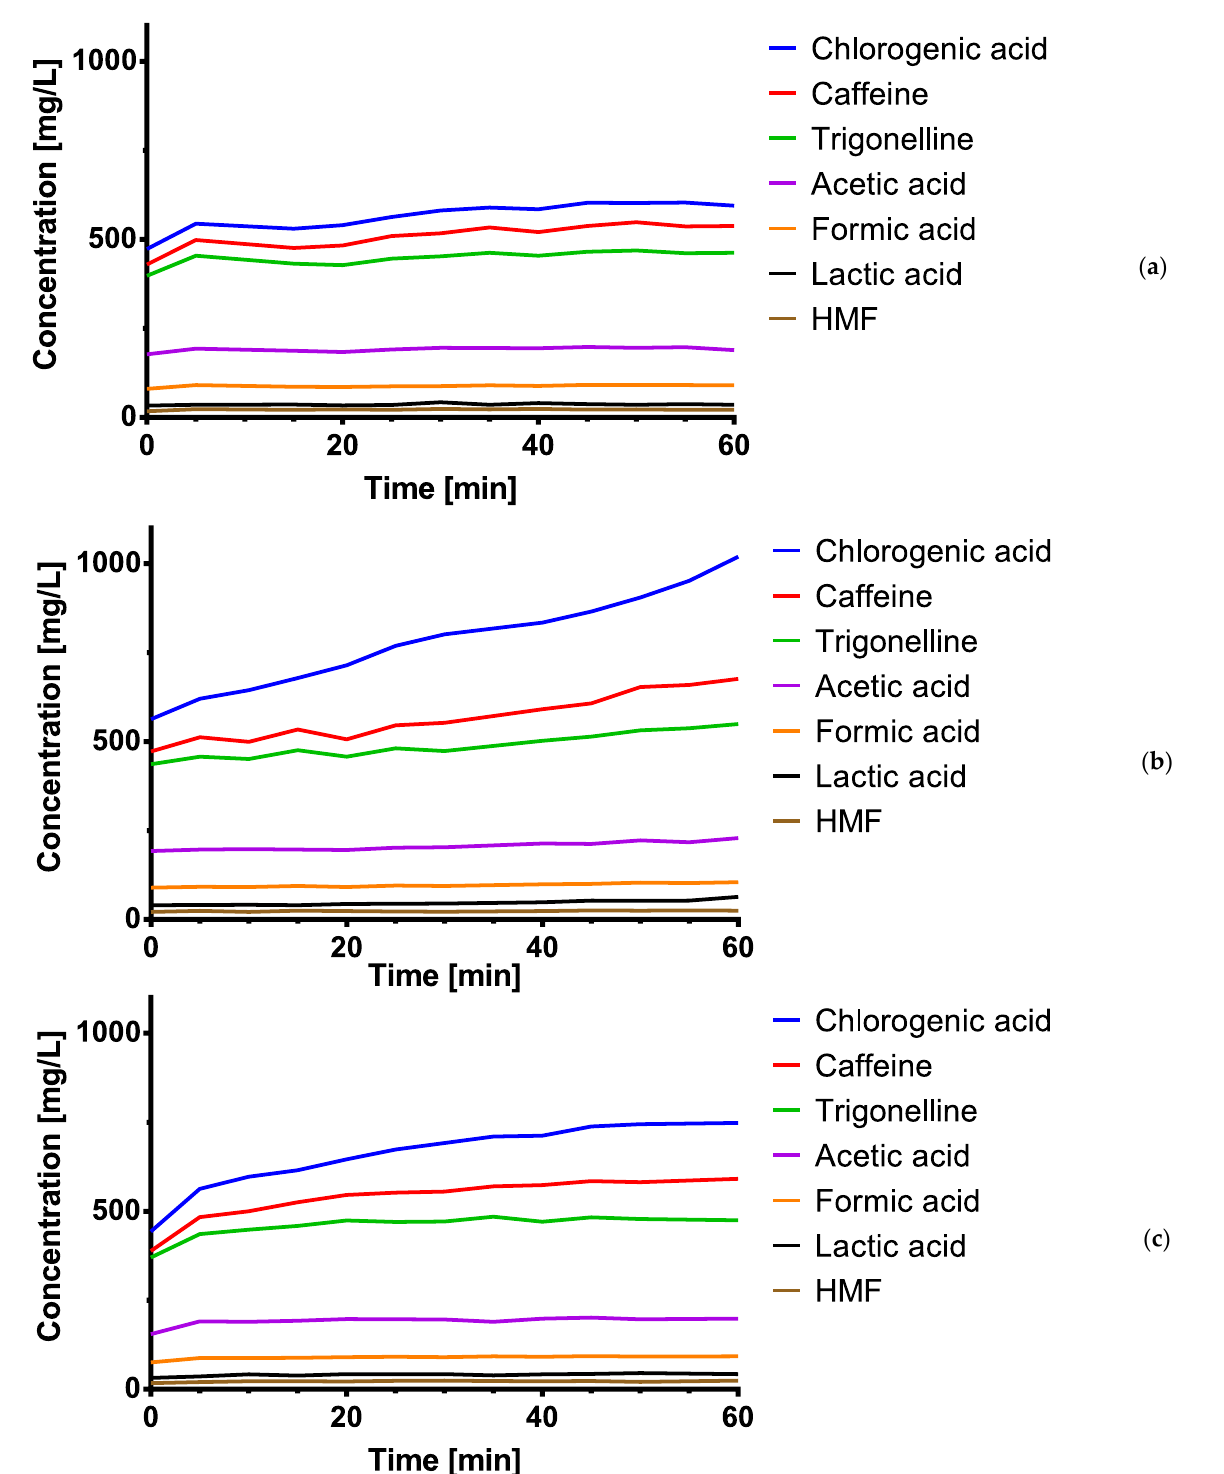
Figure 8. Graphical representation of the extraction process measuring points every 5 min: ( a ) without agitation; ( b ) with ultrasonication; ( c ) with constant agitation ( n = 1). Table 4. Percentage increase in the amount of substance after a one-hour cold brew extraction with the specified method compared to an extraction without agitation.